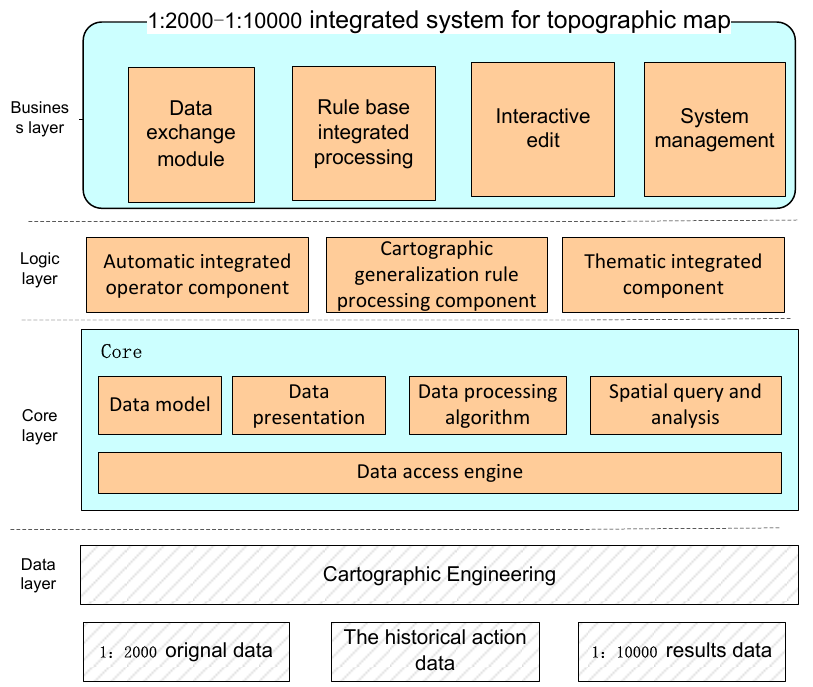
Figure 2 The integrated system for topographic